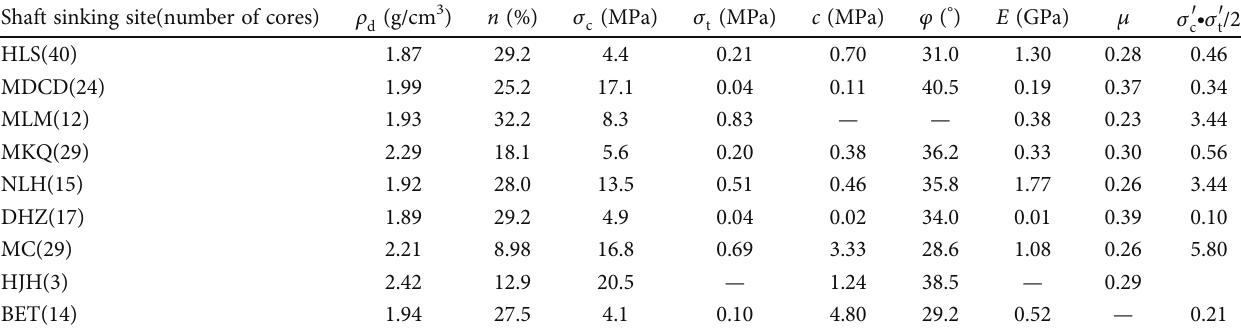
Table 2: Upper/lower limits of physical and mechanical indexes of Cretaceous sandstone cores. Shaft sinking site(number of cores)